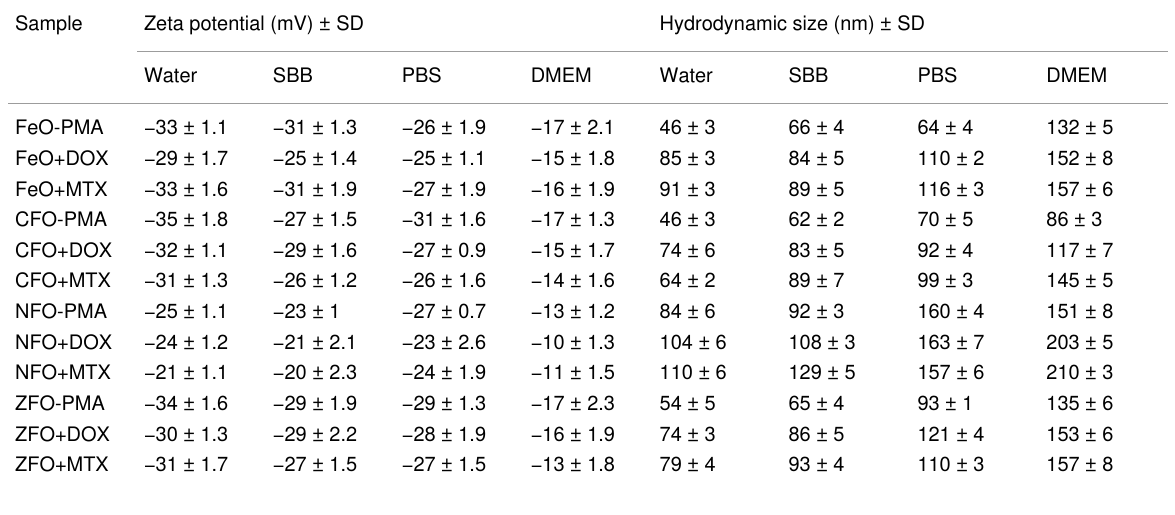
Table 4: Zeta potential, and average hydrodynamic diameter ( D z ) values of MFe 2 O 4 (M = Fe, Co, Zn, Ni) NPs by DLS.